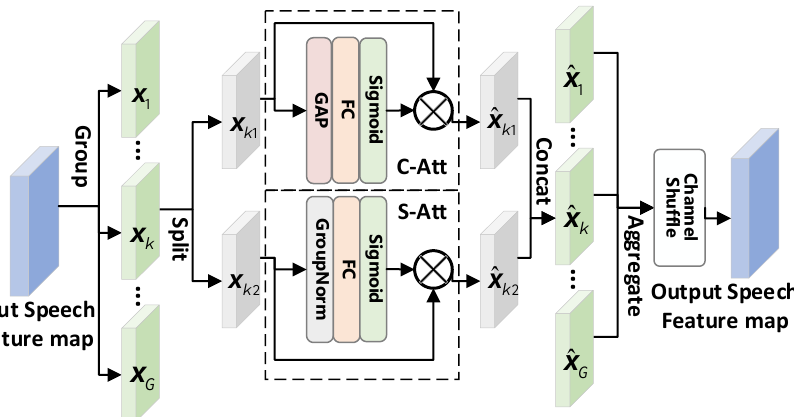
Figure 3. Shuffle Attention Mechanism, with Channel Attention (C-Att) and Spatial Attention (S-Att). GAP represents global average pooling, and FC represents Full Connection (i.e., 𝝎𝒙 + 𝒃 ). Channel shuffle is similar to reshape operation.